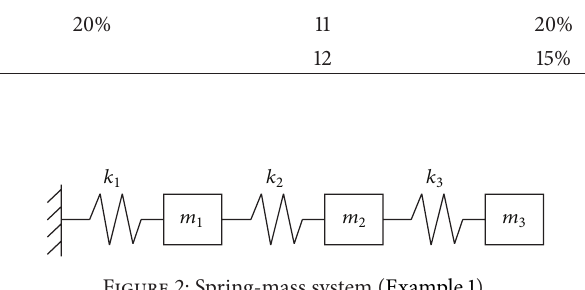
Figure 2: Spring-mass system (Example